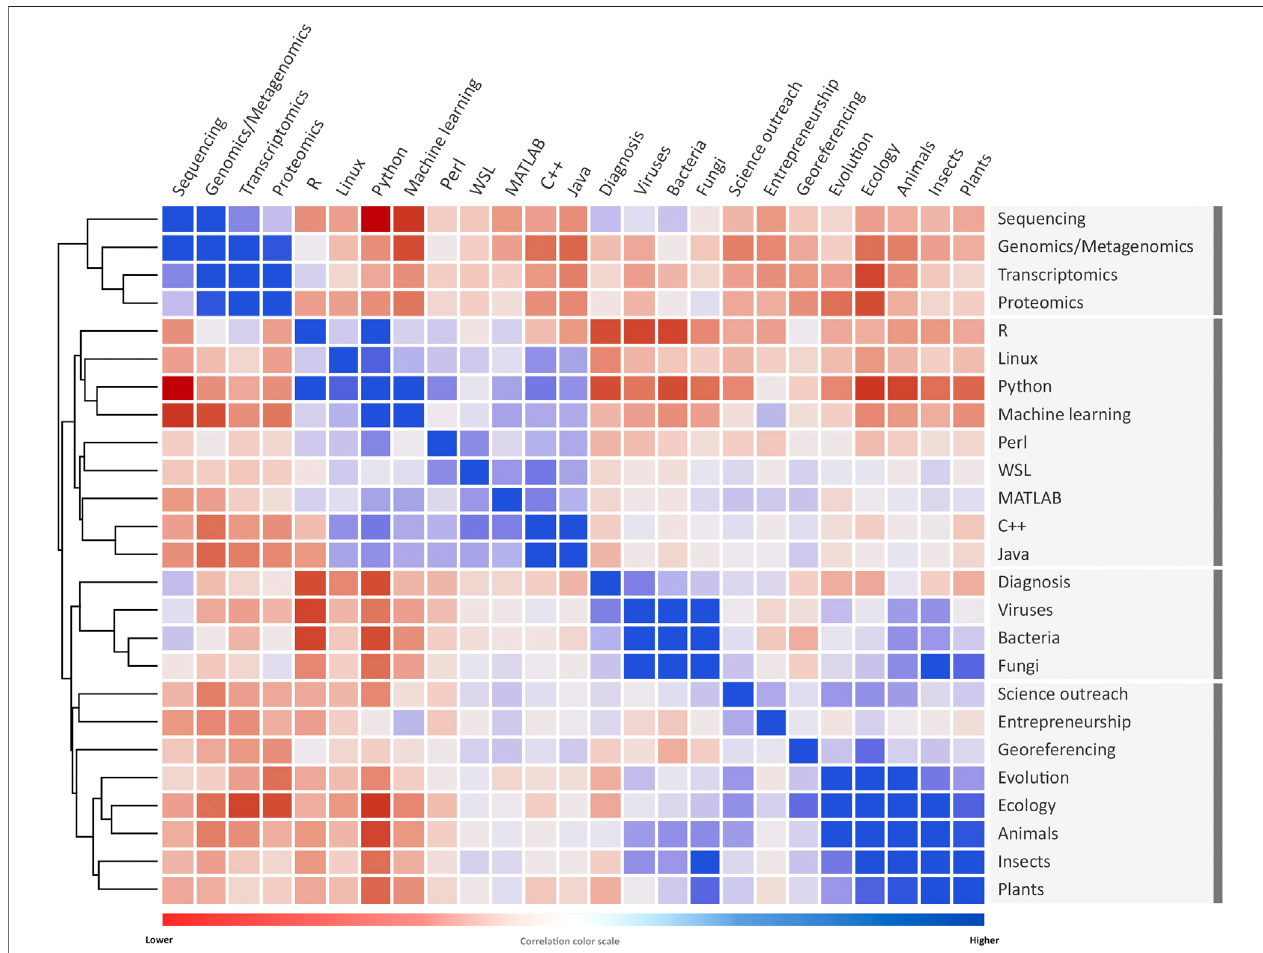
FIGURE2| Correlation colormatrixamongmostinteresttopics ofattendees enrolledintheUFMG ’ sOnlineWorkshoponBioinformatics2020(WOB).From2,727 students registered, we asked the question: “ What are the fi ve topics you are most interested in learning at WOB20? ” . Moreover, we evaluated the correlation of topic pairs. In this visualization, blue cells represent a higher correlation between topics of interest, and red indicates a lower correlation (i.e., blue suggests that students interested in topic X – column – are also interested in topic Y – row). Some clusters were highlighted in rectangles with black borders and calculated using Euclidean distance. Figure generated using Orange Data Mining